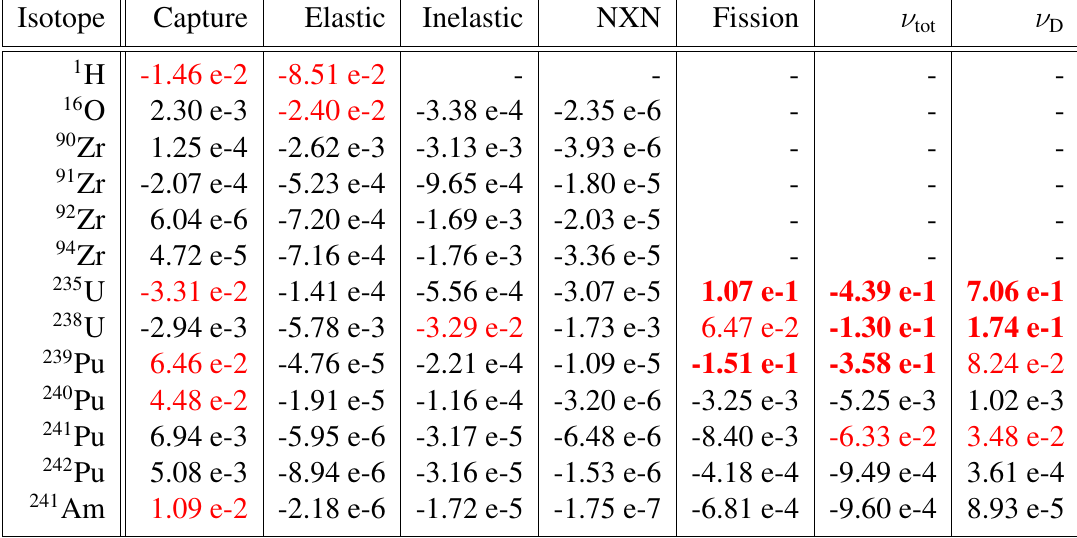
Table 1: Sensitivities (in %/%) of beta effective for the Epicure UM17x17 experiment.